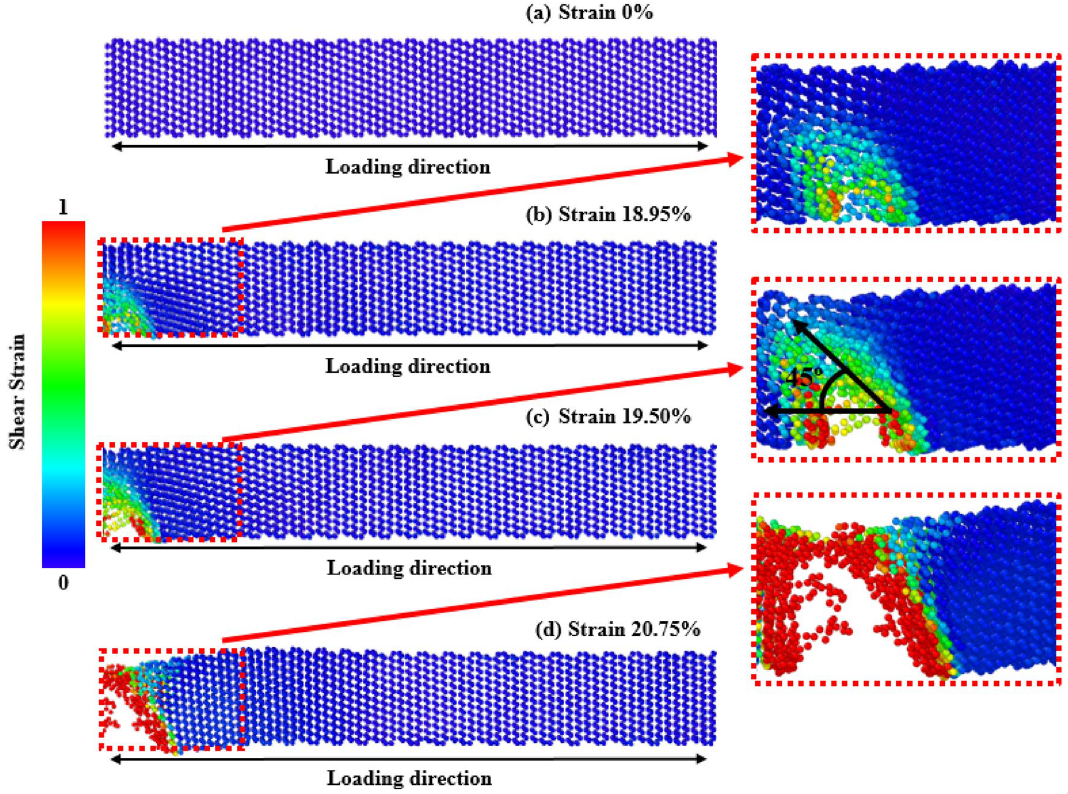
Figure 6. Tensile deformation profiles of [111] directed 15.76 nm 2 zinc-blende ZnSe NWs for various strain levels at a temperature of 300 K. Dislocation slipping induced cleavage plane along an angle of 45° with the applied tension is shown in the zoomed-in